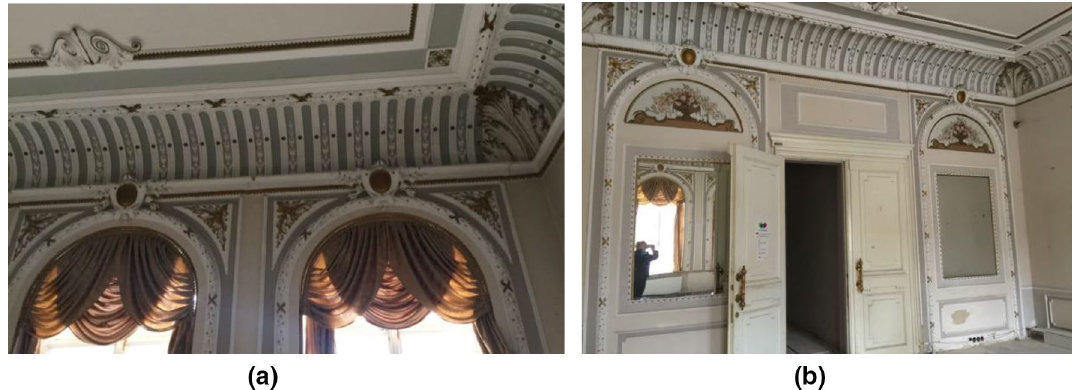
Figure 2. Interior decoration of the hall of the building: ( a ) windows, cornices; ( b ) mirrors, picturesque inserts above them, various doors.